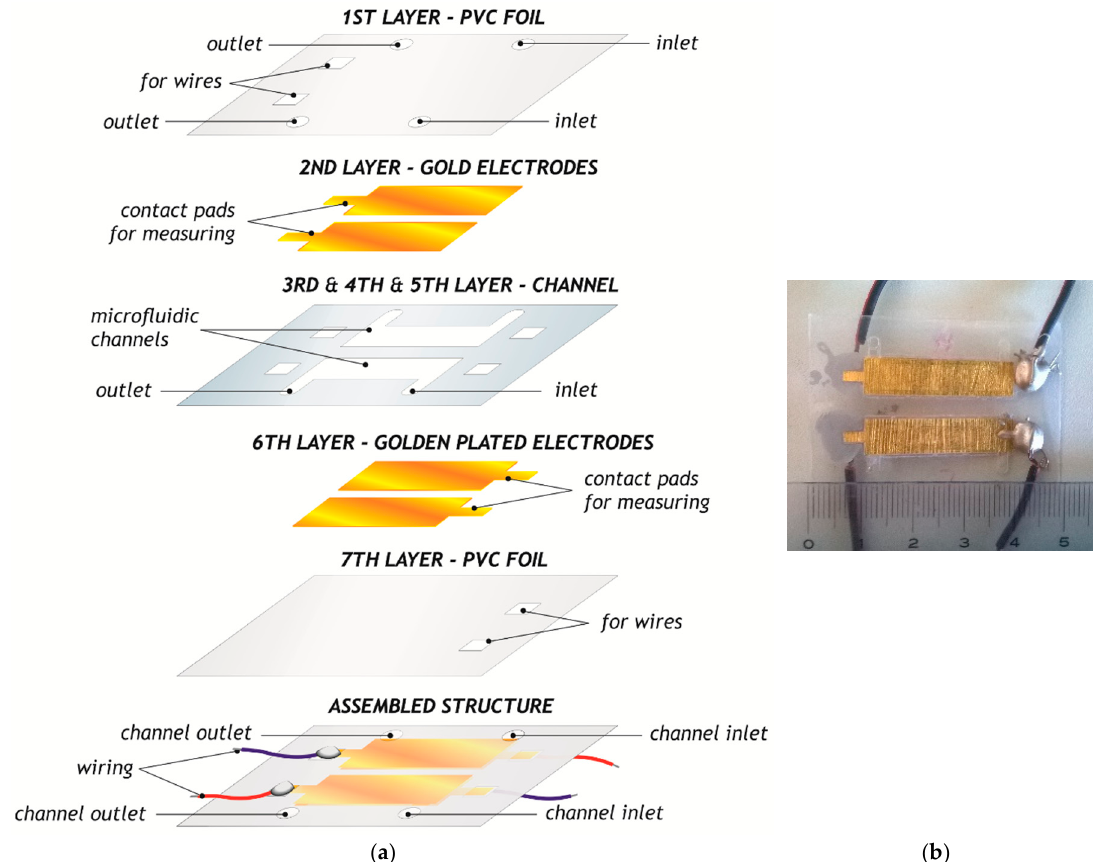
Figure 1. ( a ) Design of separate layers, and ( b ) the fabricated microfluidic-based structure.